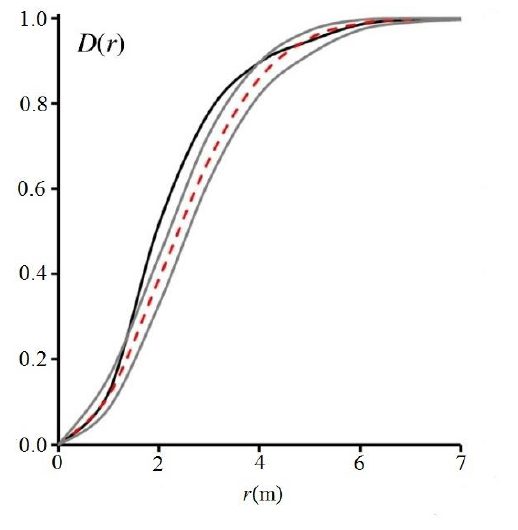
Figure 5. The results of inhomogeneous pair correlation function g ( r ) at scales of 0-40 m for eshnan shrubs.